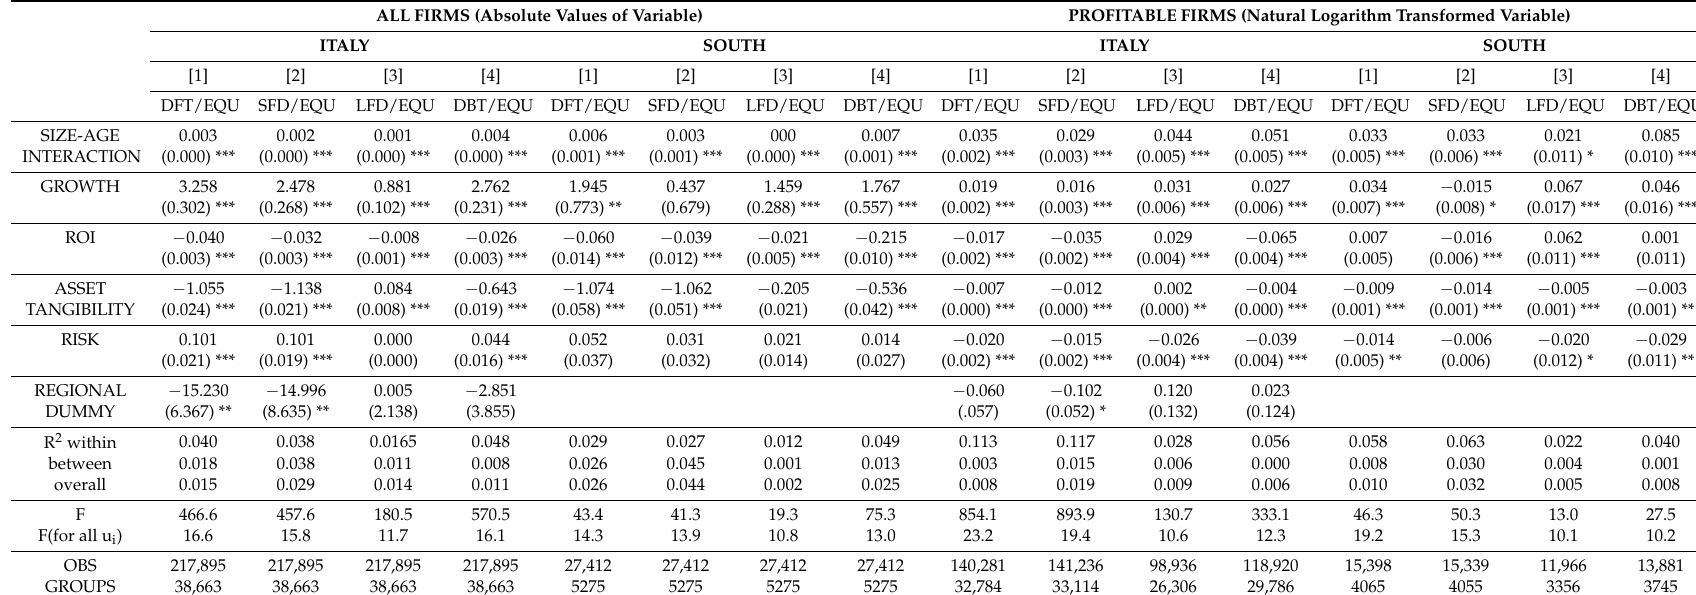
Table 5. Panel estimation for ITALY and SOUTH [2001–2013